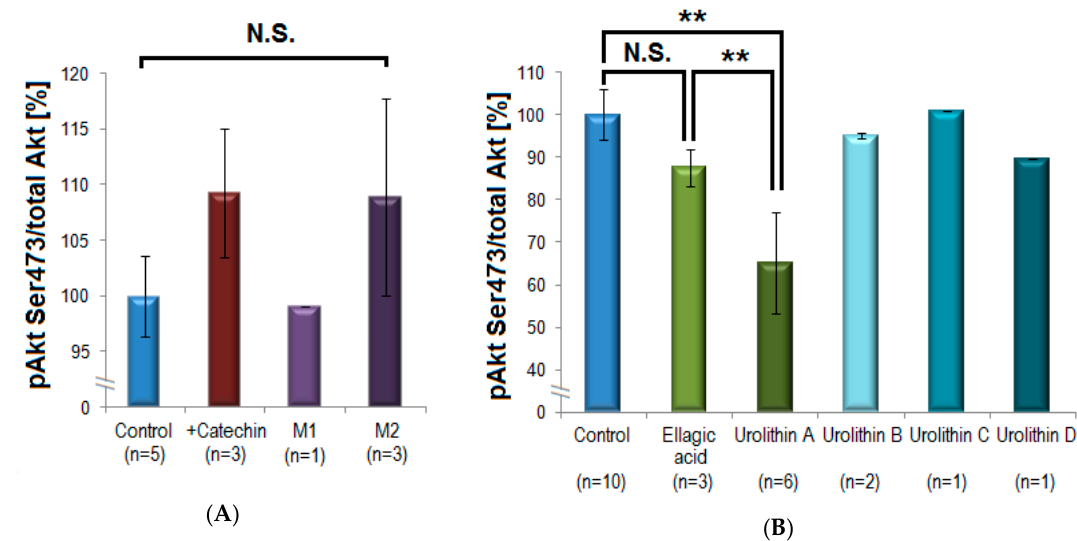
Figure 5. Investigation of a potential bio-activation of polyphenols by intestinal bacteria. ( A ) (+)-Catechin was compared with its microbiota-generated metabolites M1 and M2. (+)-Catechin and M2 caused non-significant (N.S.) slight increase in Akt-phosphorylation, M1 showed no activity. ( B ) Ellagic acid did not significantly influence the phosphorylation of Akt. In contrast, its microbial metabolite urolithin A induced a pronounced and statistically significant inhibition of Akt-phosphorylation compared to control (** p = 0.001, mean ± standard deviation) and compared to ellagic acid (** p = 0.005, one-way ANOVA/Tukey post-hoc test). Other urolithins showed only minor inhibitory effects (n = 3–6 for (+)-catechin, M2, ellagic acid, and urolithin A, n = 1–2 for other compounds).